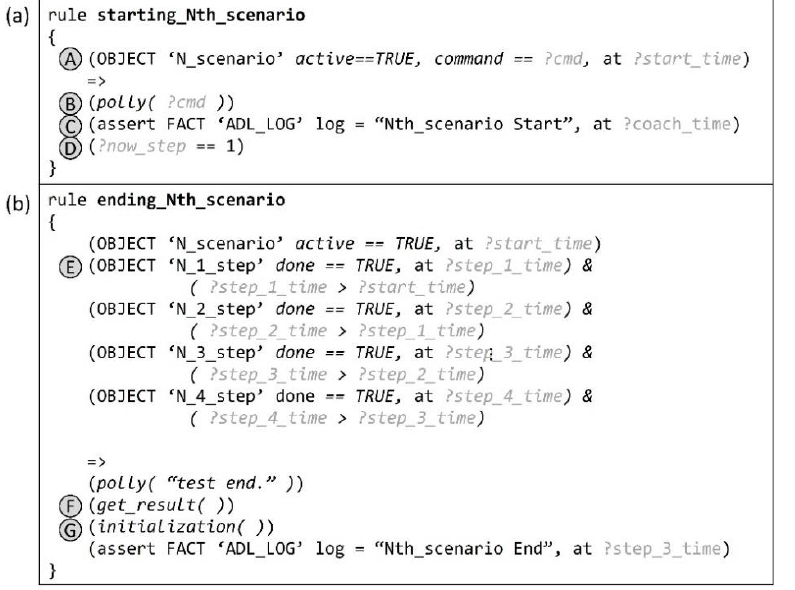
Figure 10. ( a ) Rule for starting an Nth scenario. ( b ) Rule for ending an Nth scenario when the user has performed all steps in the